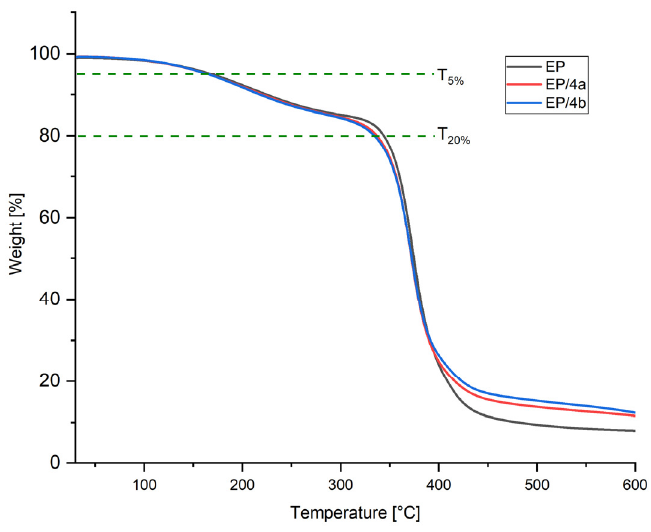
Figure 6. TGA curves of EP and EP incorporated with compounds 4a and 4b . Table 3. Thermal properties of EP and modified